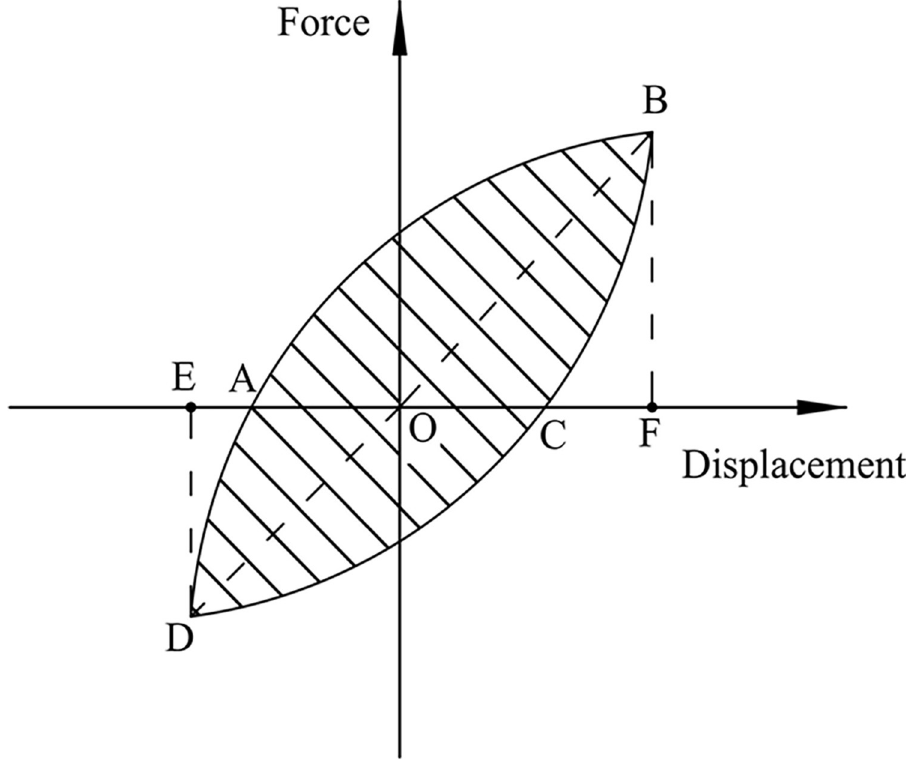
Fig 23. Hysteresis